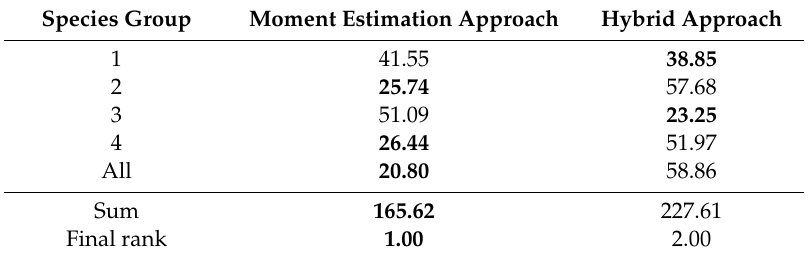
Table 5. Sum of the relative rank a , by species group and prediction approach.